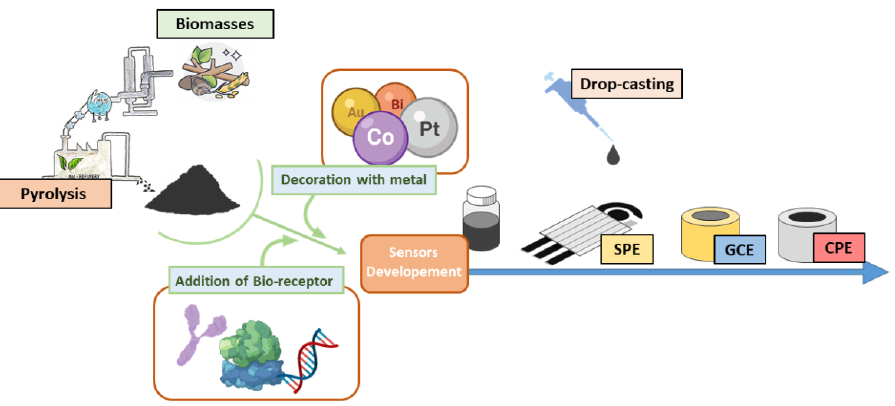
Figure 3. Schematic representation of the steps involved in the fabrication of biochar ‐ modified electrodes.